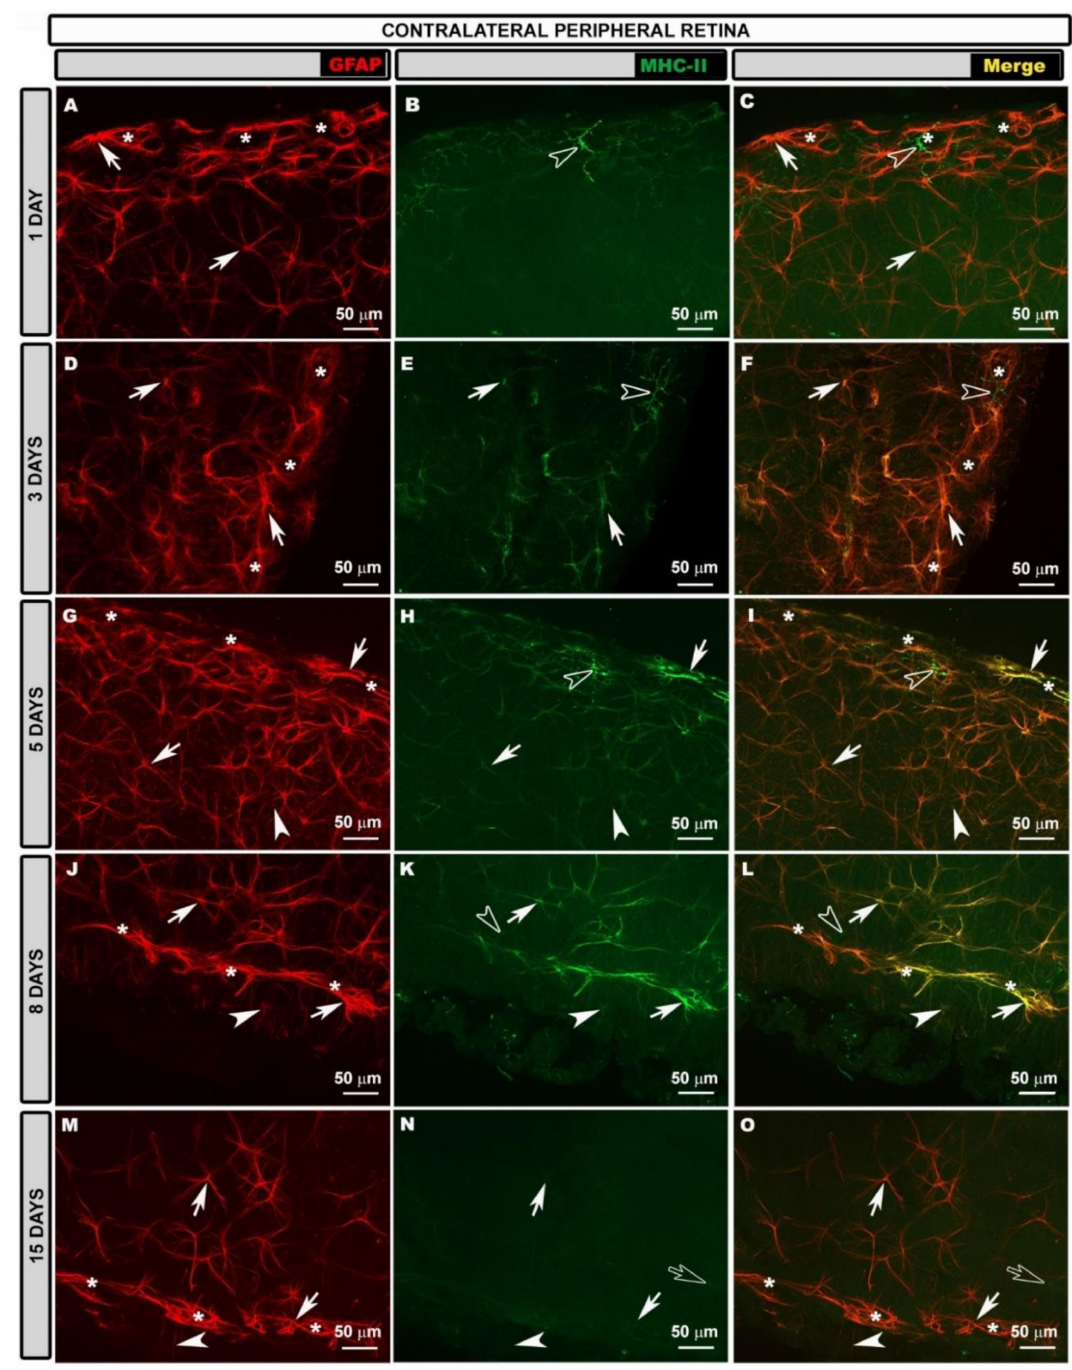
Figure 3. Retinal whole-mount. Double immunostaining for GFAP (red) and MHC-II (green) at different time points after OHT induction in contralateral eyes in the peripheral retina. GFAP-labeled astrocytes are shown at different time points ( A , D , G , J , M ). In the peripheral retina, astrocytes (arrow) showed intense MHC-II expression that was comparable to that of dendritic cells (hollow arrowhead) at all time points (1 ( B , C ); 3 ( E , F ); 5 ( H , I ); and 8 ( K , L ) days) after laser tr.eatment except at 15 ( N , O ) days, at which time microglia (hollow arrow) also expressed MHC-II. MHC-II immunolabeling in Müller glia (arrowhead) was observed at 5 ( H , I ); 8 ( K , L ); and 15 ( N , O ) days. Asterisks mark circular peripheral blood vessel. GFAP: glial fibrillary acidic protein; MHC-II: major histocompatibility complex class II; OHT: ocular